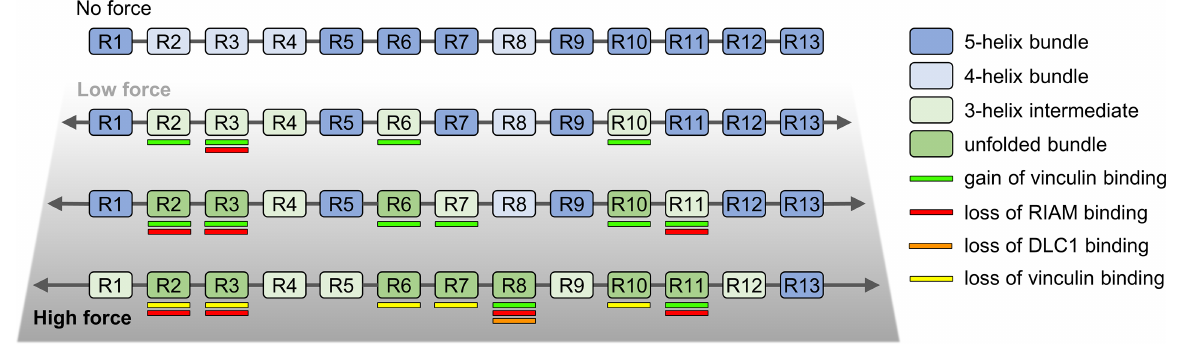
Fig 7. Schematic representation of talin rod unfolding through stable 3-helix intermediates. Without force, the talin rod subdomains remain intact and no VBSs are exposed. Under low load weak 4-helix bundles unfold to stable 3-helix intermediates. As the force increases, some of the 5-helix bundles unfold, forming the 3-helix intermediates along talin rod structure. Force-regulated unfolding of the talin rod changes affinity to different binding partners. RIAM and DLC1 are known to bind folded bundles, while recruitment of vinculin requires partial or complete unfolding of rod domains. VBSs that are located at terminal helices of the R2, R6, R7, and R10 bundles become available after unfolding to the 3-helix state (panel “Low force”).